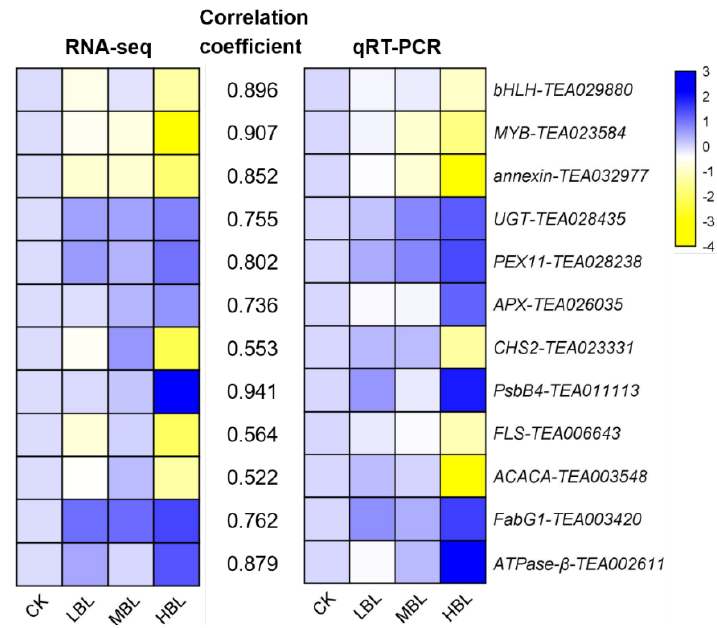
Figure 2. Validation and correlation analysis of 12 selected DEGs. The values between two heatmaps represent the correlation coe ffi cients of qRT-PCR and RNA-seq values from each gene.